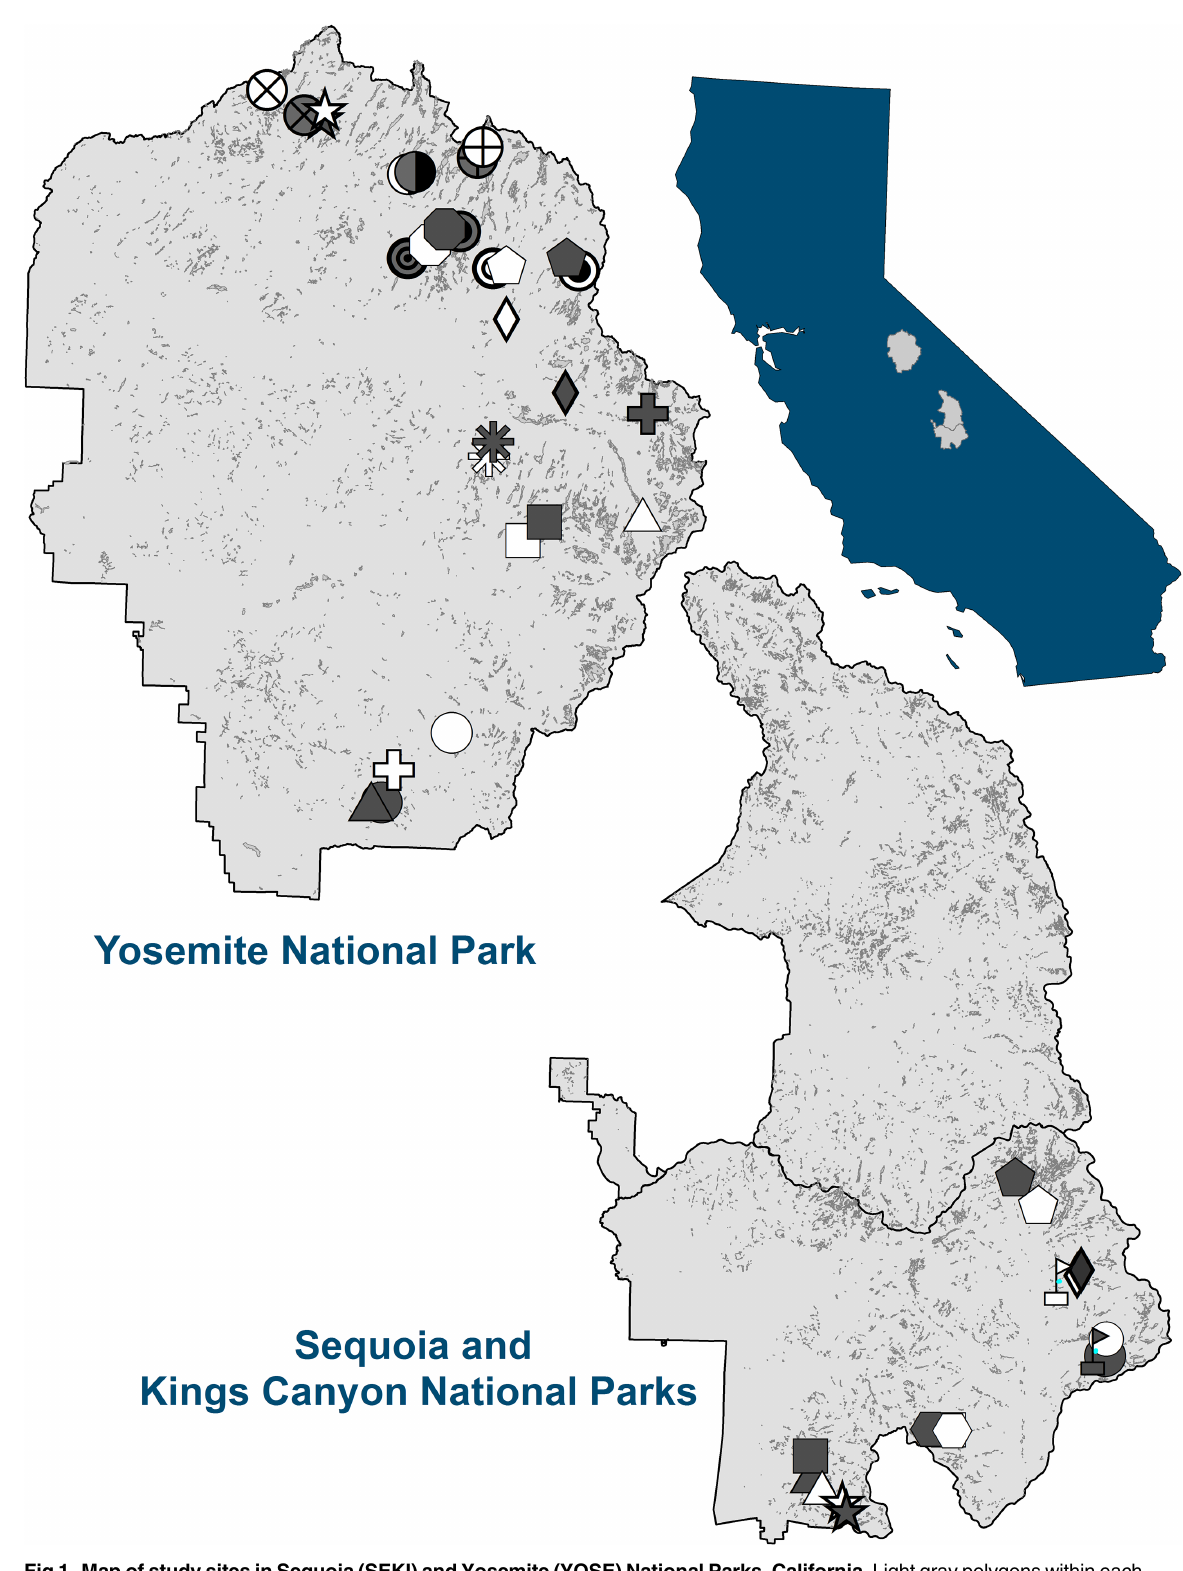
Fig 1. Map of study sites in Sequoia (SEKI) and Yosemite (YOSE) National Parks, California. Light gray polygonswithin each park represent mappedmeadowunits. The locationof sampledmeadowpairs are representedby matchingsymbols. White symbols are pack stock meadowswhiledark gray symbols are non-pack stock meadows. https://doi.org/10.1371/journal.pone.0178536.g001 PLOS ONE | https://doi.org/10.1371/journal.pone.0178536 June 13,